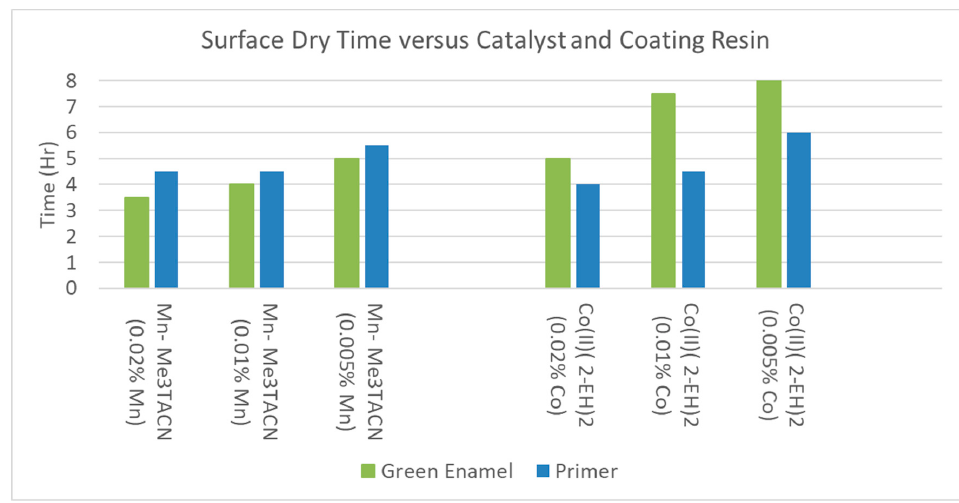
Figure 7. Dry times of [Mn IV2 ( μ -O) 3 (Me 3 TACN) 2 ](PF 6 ) 2 (abbreviated as Mn- Me 3 TACN) versus Co II